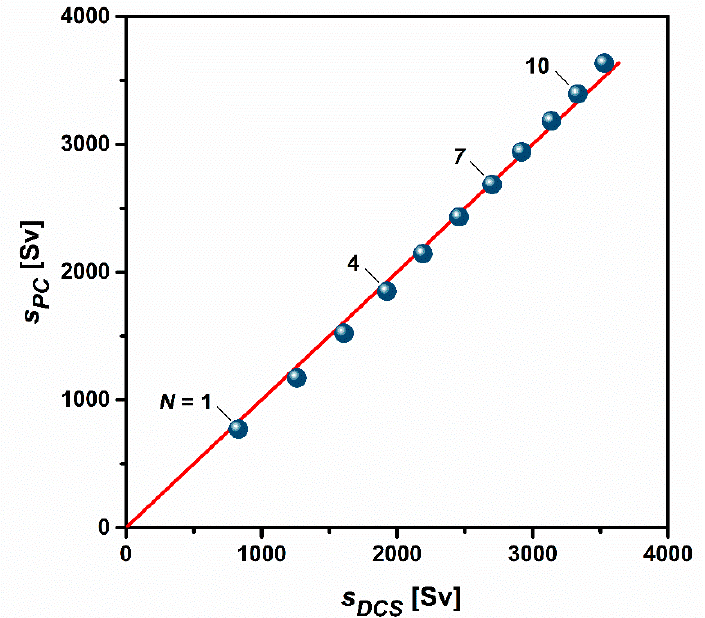
Figure 5. Cross-comparison of sedimentation coefficients shows excellent agreement between the quantities determined by DCS and those estimated from preparative centrifugal separation. The bisecting red line is added for ease of classification and to indicate deviations from full conver- gence.